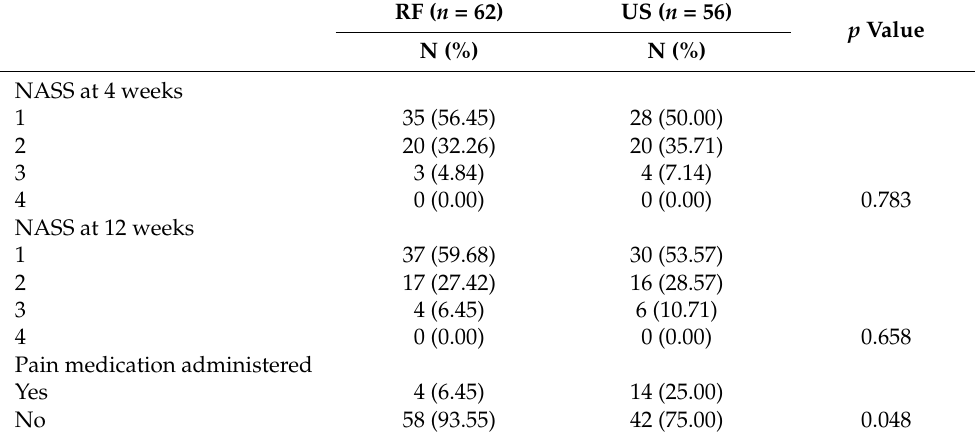
Figure 2. Successful rate of pain relief and functional improvement in both groups. The radiofre- quency (RF) group showed a significantly higher rate of successful pain relief at 12 weeks after treatment compared to the ultrasound (US) group ( p < 0.05), while no significant difference was found at 4 weeks after treatment. ( A ) Successful rate of pain relief at 4 weeks, ( B ) successful rate of pain relief at 12 weeks, ( C ) successful rate of functional improvement at 4 weeks, ( D ) successful rate of functional improvement at 4 weeks.* p < 0.05. Table 4. NASS patient-satisfaction index and intake of pain